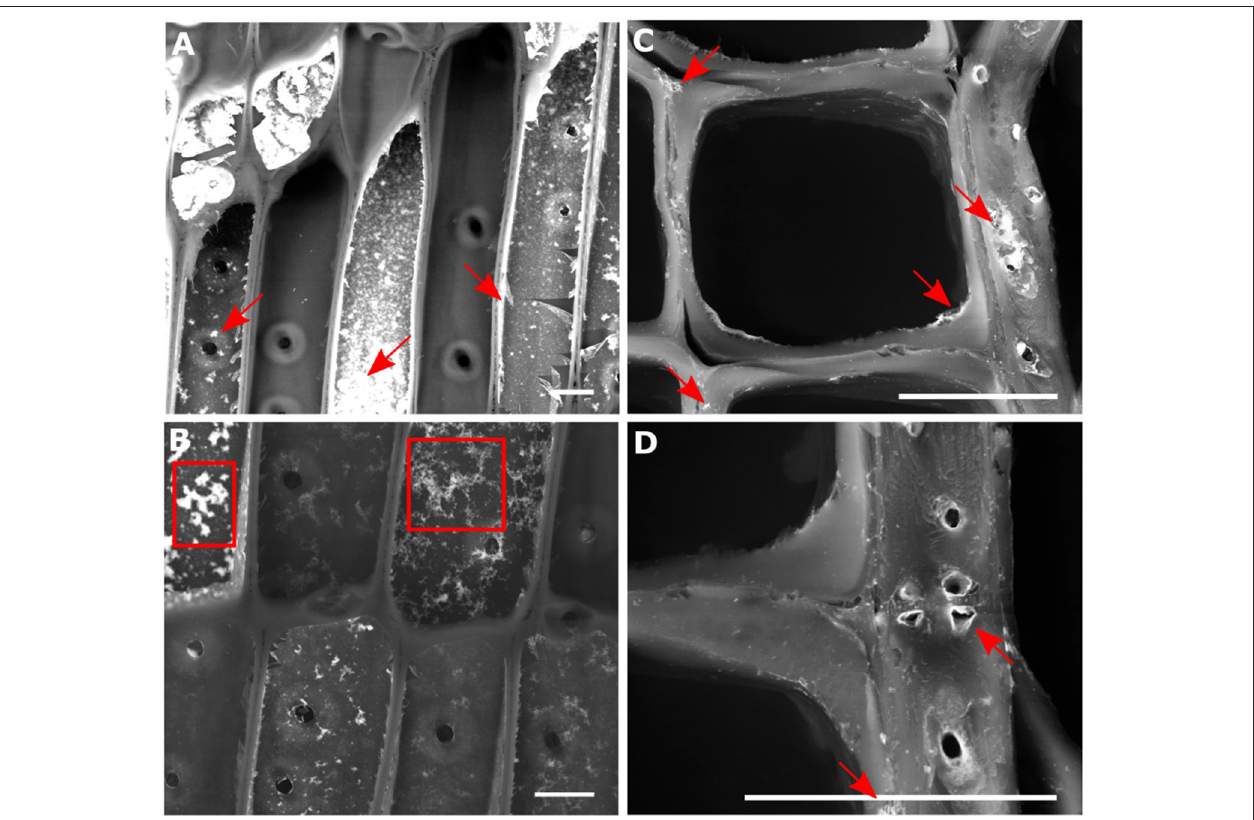
FIGURE 2 | Backscattered electron micrograph of a longitudinal tangential (LT) cut (A,B) and cross section (C,D) through spruce wood infiltrated with Eu:HfO 2 nanoparticles. Agglomerated (marked with arrows) and fractals [boxes in (B) ] formed at the interface between lumen and cell wall are clearly visible, while isolated nanoparticles cannot be resolved. Scale bar = 20 µ